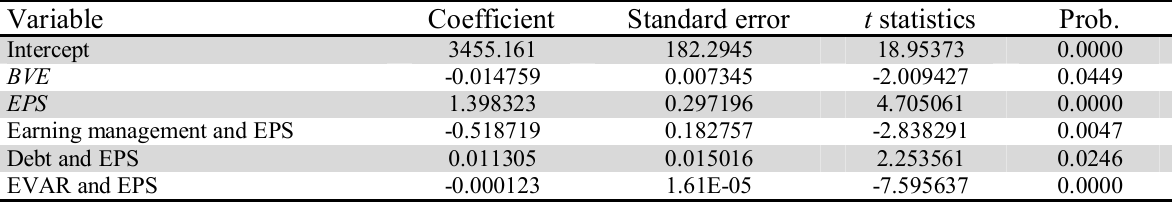
The summary of regression analysis